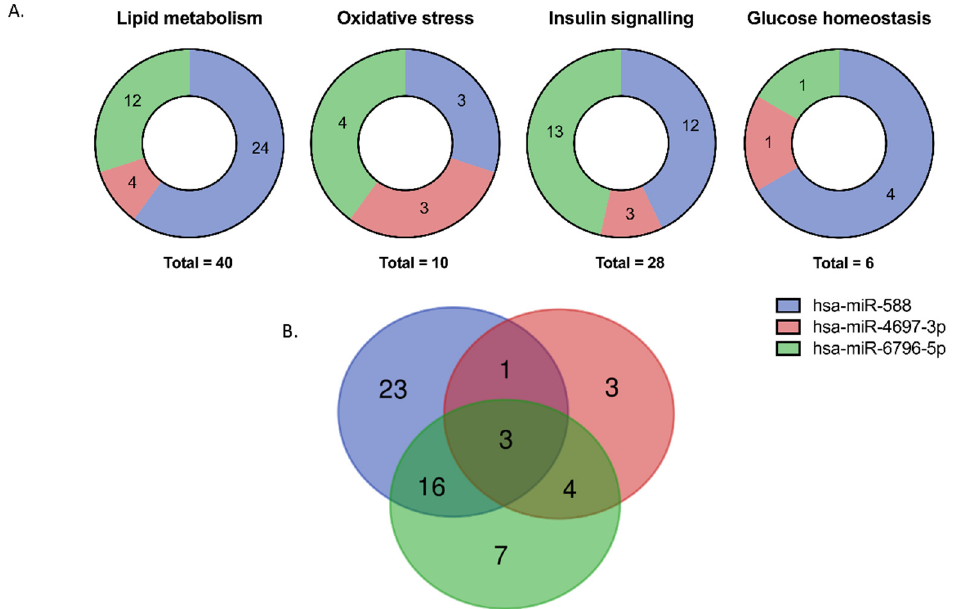
Figure 5. ( A ) Pie charts showing the numbers of affected metabolic processes by each validated miRNA in each main pathway (lipid metabolism, oxidative stress, insulin signalling, and glucose homeostasis). ( B ) Venn diagram of unique and shared processes by each validated miRNA. The different miRNAs are coded by colour. Analysis performed at https://reactome.org, (accessed on 11 March 2020) with the target genes for each miRNA according to miRcarta v1.1 (details in Table S3).